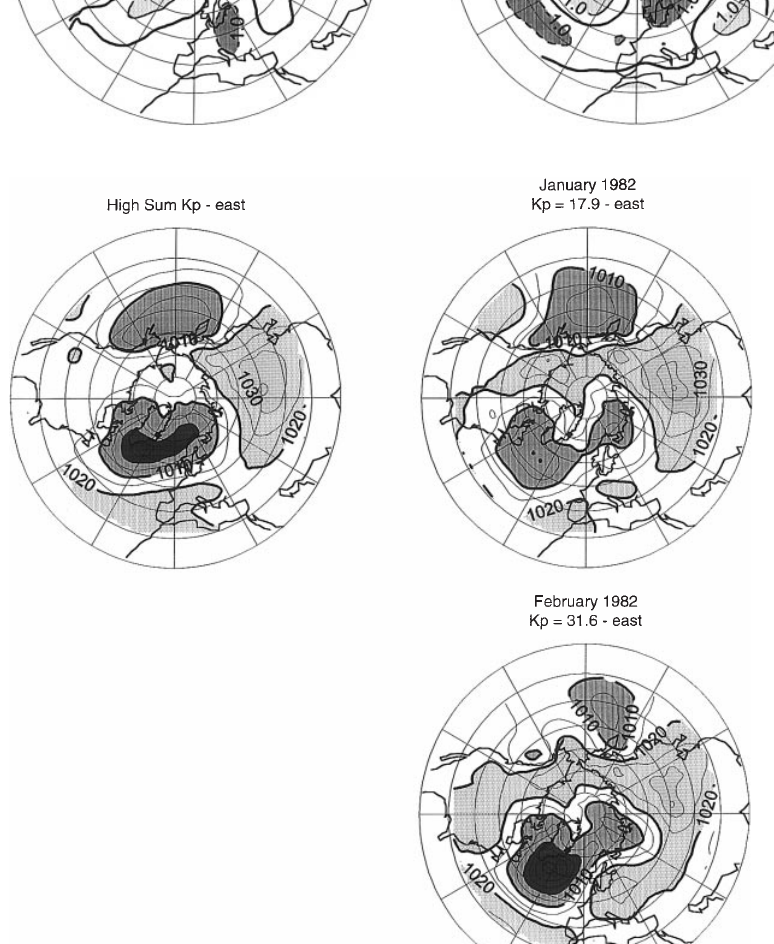
Fig. 3. Distribution of temperature devia- tions from a long term average (1952–1996) at di(cid:128)erent levels of geomagnetic activity and at di(cid:128)erent QBO-phases (positive, solid lines ; negative, dashed lines ). The intervals between contours is 1 (cid:176) C